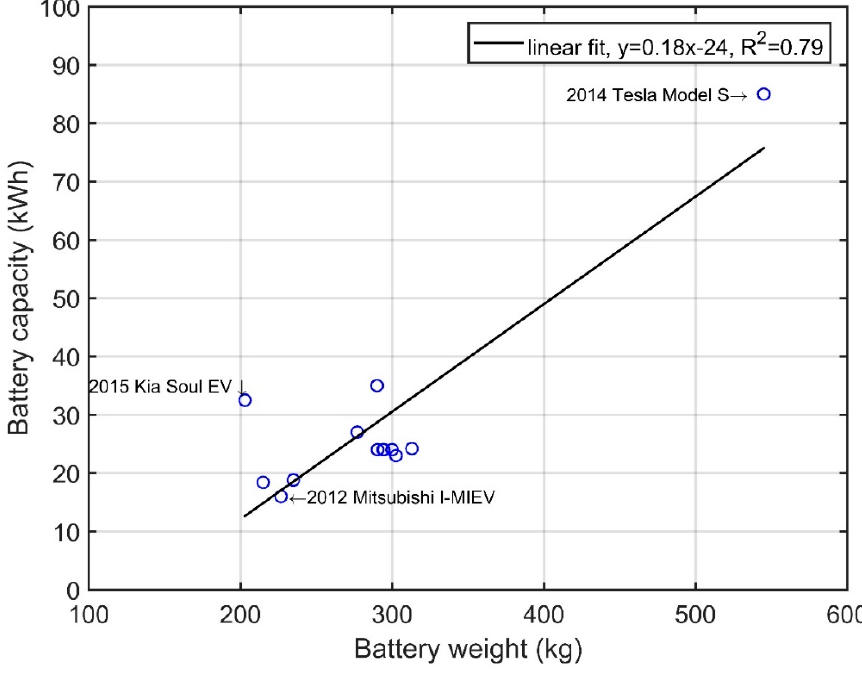
Figure 7. Battery capacity over battery weight relationship.